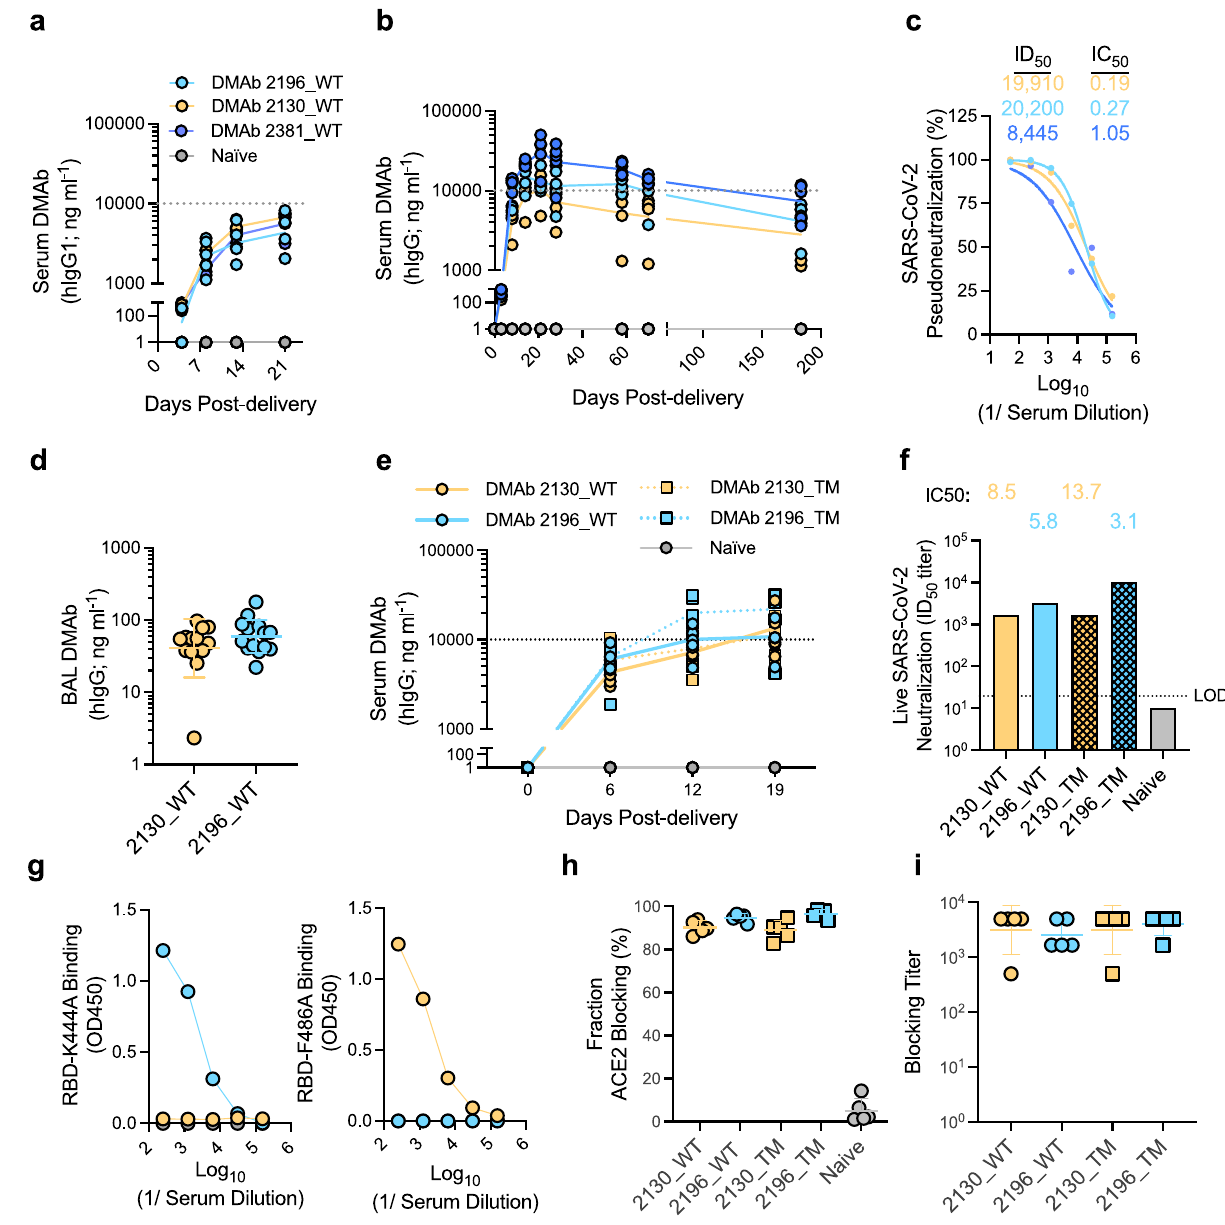
Fig. 1 | Expressionand characterizationofin vivo-launchedSARS-CoV-2 DMAb constructs. WT DMAb expression (100 μ g dose) following a single plasmid ( n =5 (2196_WT and 2130_WT) or 4 (2381_WT) independent biological replicates) or b dualplasmid constructs ( n =5) wasmeasured in the sera of6 – 8-week-old female BALB/c mice. Serum DMAb titers for individual mice over time are shown. Lines indicate the group geometric means (GM). c Neutralization of pseudotyped SARS- CoV-2 (USA-WA1/2020) by serum pools (from panel b ). Neutralization curves for eachpoolareshown(best fi tlinesandindividualdatapointsderivedfromtechnical replicates); ID50 and calculated IC50 values are displayed. d DMAb levels in the lung bronchoalveolar lavage (BAL) of 6 – 8-week-old female BALB/c mice at D14 post-plasmid delivery(100 μ gdose; n =13(2130_WT)or14(2196_WT)independent biological replicates). Titers for individual mice are shown with group GM (±geo- metric standard deviation (GSD)) indicated. e-i Expression and characterization of